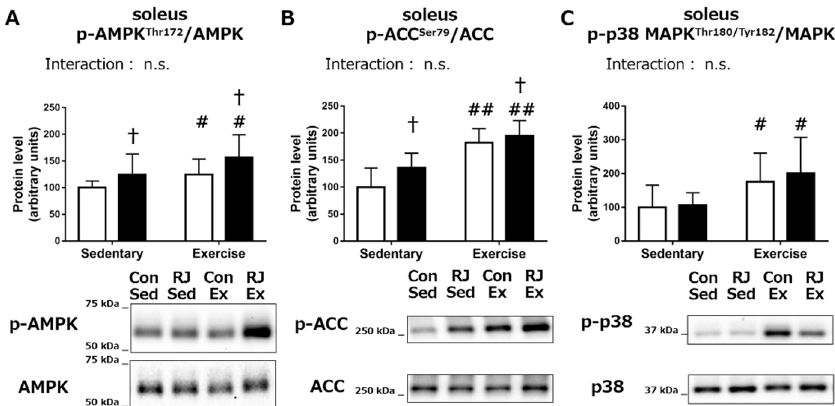
Figure 3. ( A ) 5'-AMP-activated protein kinase (AMPK), ( B ) acetyl-CoA carboxylase (ACC), and ( C ) p38 mitogen-activated protein kinase (p38 MAPK) phosphorylation status in the soleus muscle of mice that treated with a single dose of royal jelly (RJ-treated group; black) or distilled water (Control group; white) and with or without an endurance exercise (Acute experiment). Values represent mean ± standard error. n = 6–7 per group. # p < 0.05 and ## p < 0.01, main effect of endurance exercise. † p < 0.05,